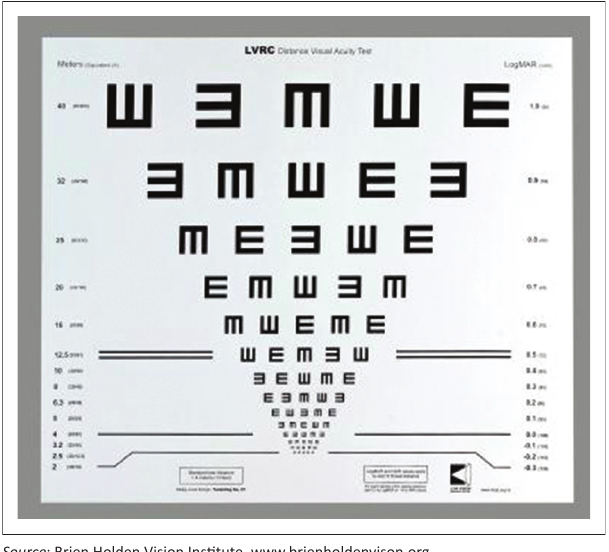
Source : Brien Holden Vision Institute, www.brienholdenvison.org FIGURE 2: Standard logMAR chart used for